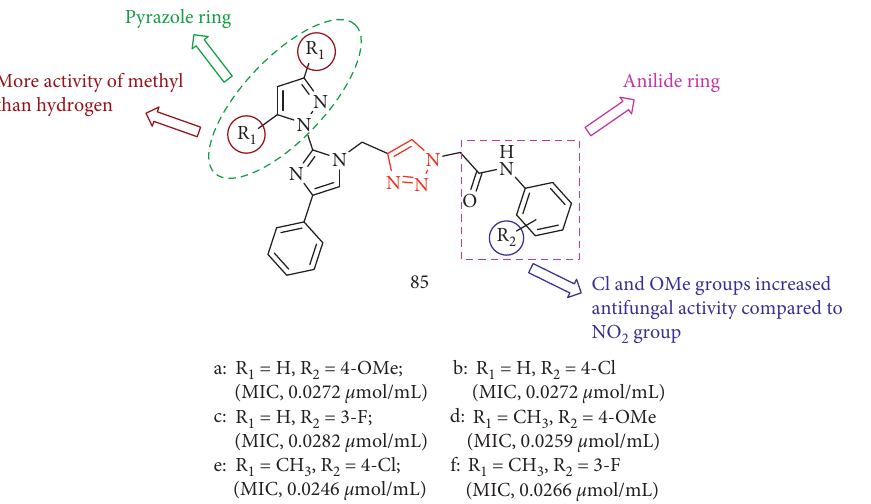
Figure 35: Chemical structure of pyrazole-imidazole-triazole hybrids.